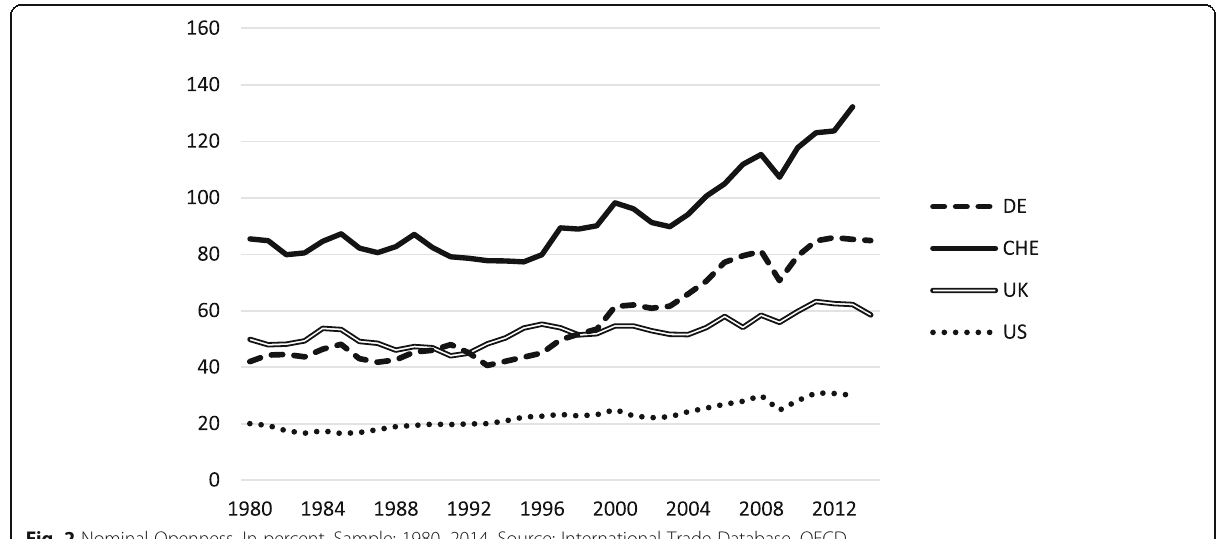
Fig. 2 Nominal Openness. In percent. Sample: 1980 – 2014, Source: International Trade Database,